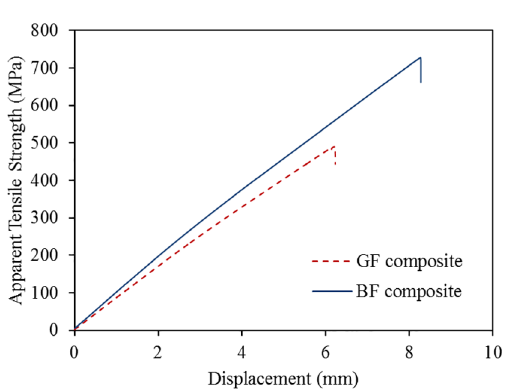
Figure 6. Split disk test tensile-displacement curves of BF and GF composites.